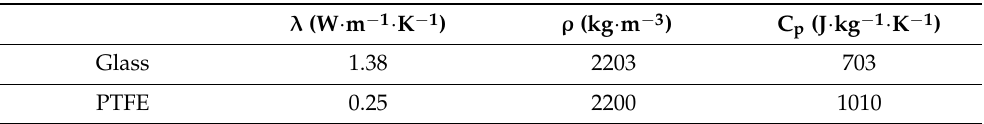
Table 2. Thermophysical characteristics of different